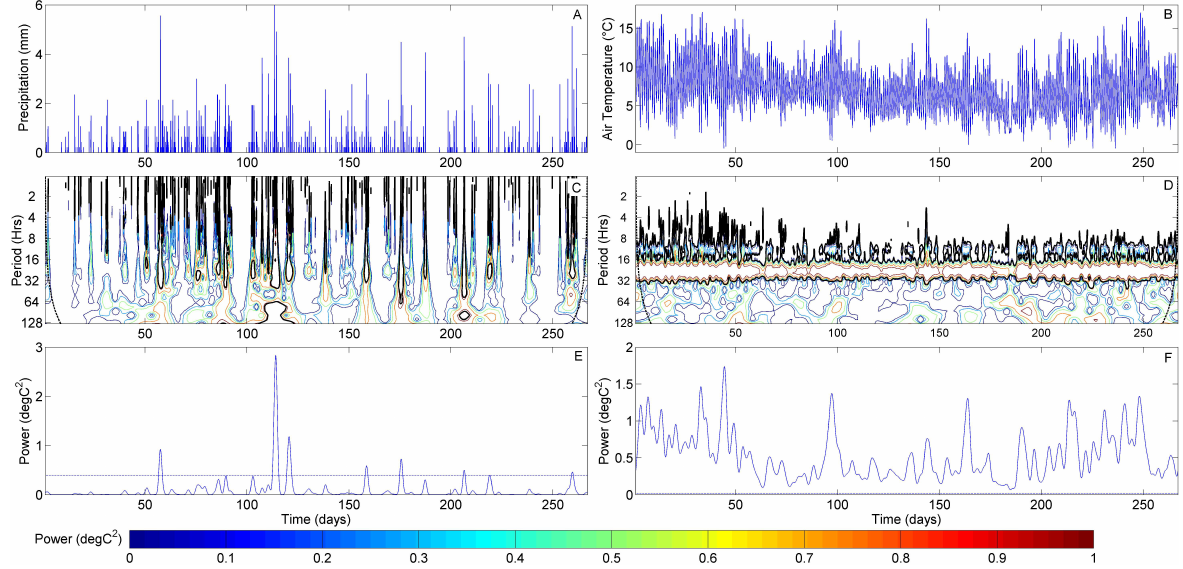
Fig. 5. Wavelet analysis outputs for rainfall ( A , C , and E ) and air temperature time series ( B , D , and F ): (A–B) averaged normalized rainfall (A) , and air temperature (B) time series. (C–D) local wavelet power spectrum normalized by their standard deviations. The black line delineates the areas where the power is significant (i.e., exceeds the 95% confidence level of a red-noise process). The dashed black line delineates the cone of influence that delimits the region not influenced by edge effects. (E–F) normalized scale-averaged wavelet power spectra at 24h. The dashed blue line shows the corresponding 95% confidence level for the red-noise spectrum. In each panel, day one corresponds to the 1 January 2010. The color bar shows the legend for the different colors: blue and red for low and high wavelet power,